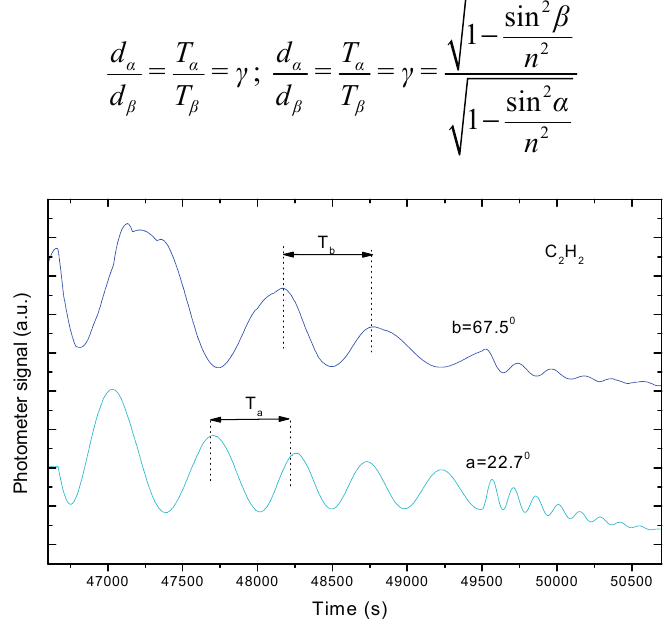
Figure 11. Graphs of interference curves produced over time with two lasers during gas-phase